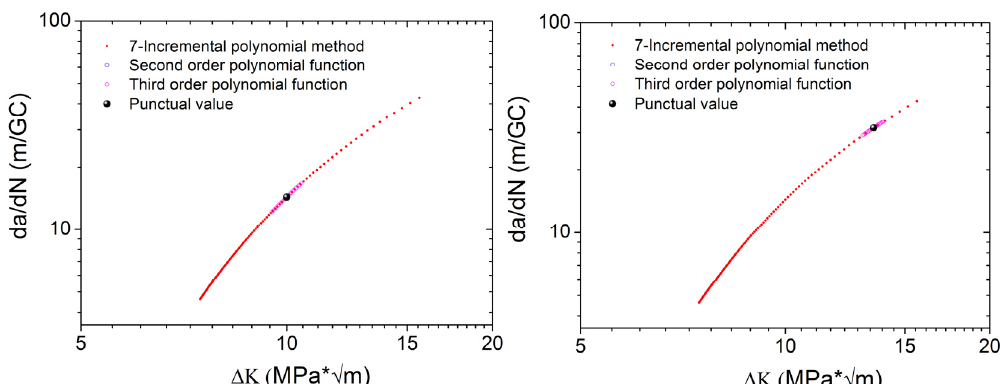
Figure 11: Crack propagation curves and local interpolation ranges.